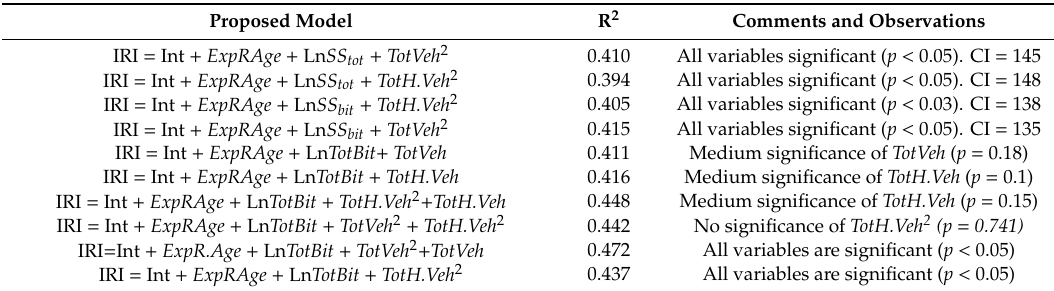
Table 5. Some of the analyzed multiple linear regression models for IRI